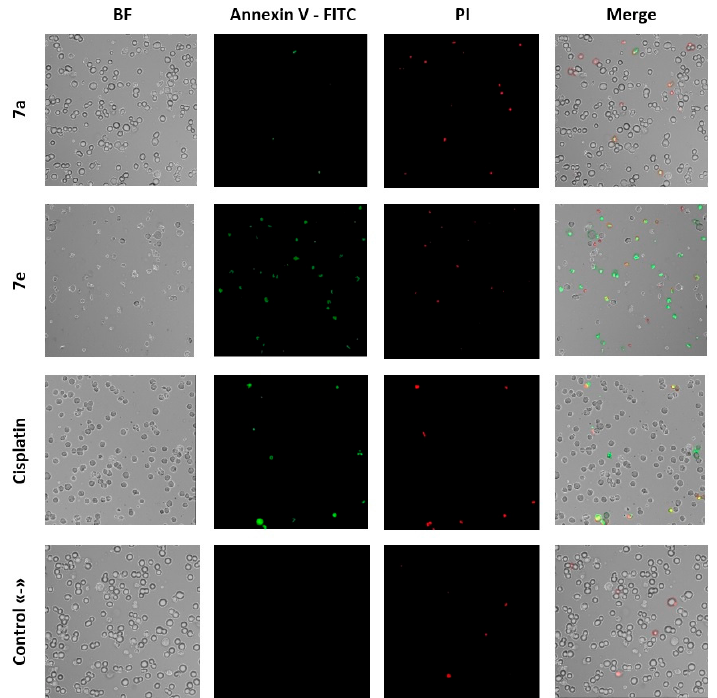
Figure 4. Fluorescence staining of human glioblastoma A-172 cells with Annexin V-FITC and PI dyes under the influence of the test substances 7a and 7e compared to cisplatin (6 μ M concentration) and intact cells. Cells in early apoptosis stained green (Annexin V-FITC), cells in late apoptosis and necrosis stained red (PI), 200× magnification.